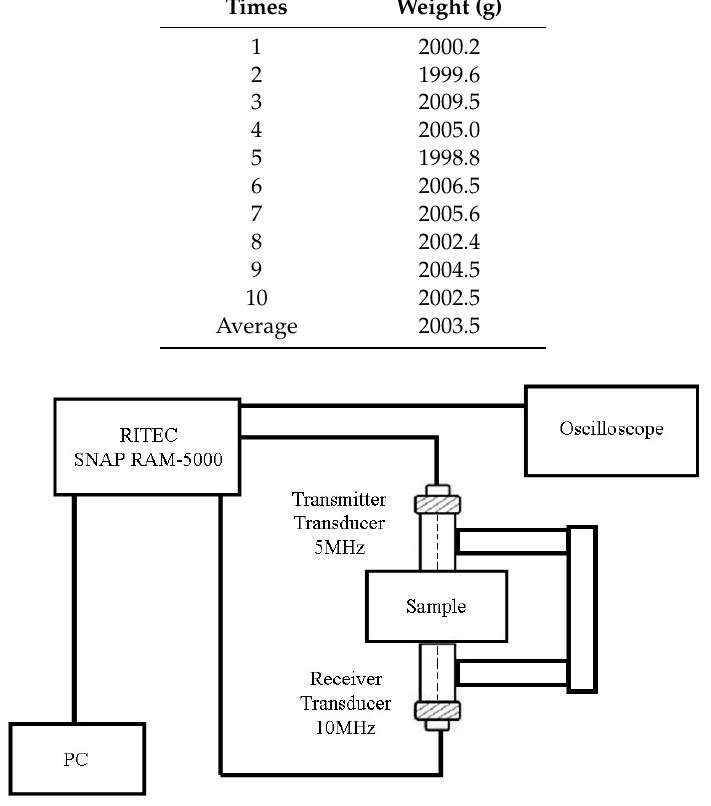
Figure 3. The sketch of the experimental setup for nonlinear ultrasonic measurement.